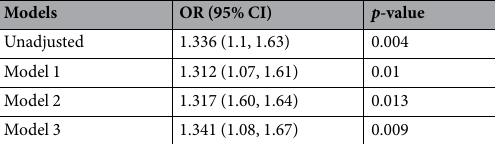
Table 3. Association between blood cadmium level and psoriasis. Adjusted covariates: Model 1 = age, gender, race/ethnicity, family income, education level. Model 2 = Model 1 + (hypertension, coronary heart disease, arthritis, cancer) + (Body mass index, waist circumference, alcohol consumption, former smoker, smoking dose). Model 3 = Model 2 + (white blood cell count, C-reactive protein, blood lead, blood mercury). OR, odds ratio; CI, confidence